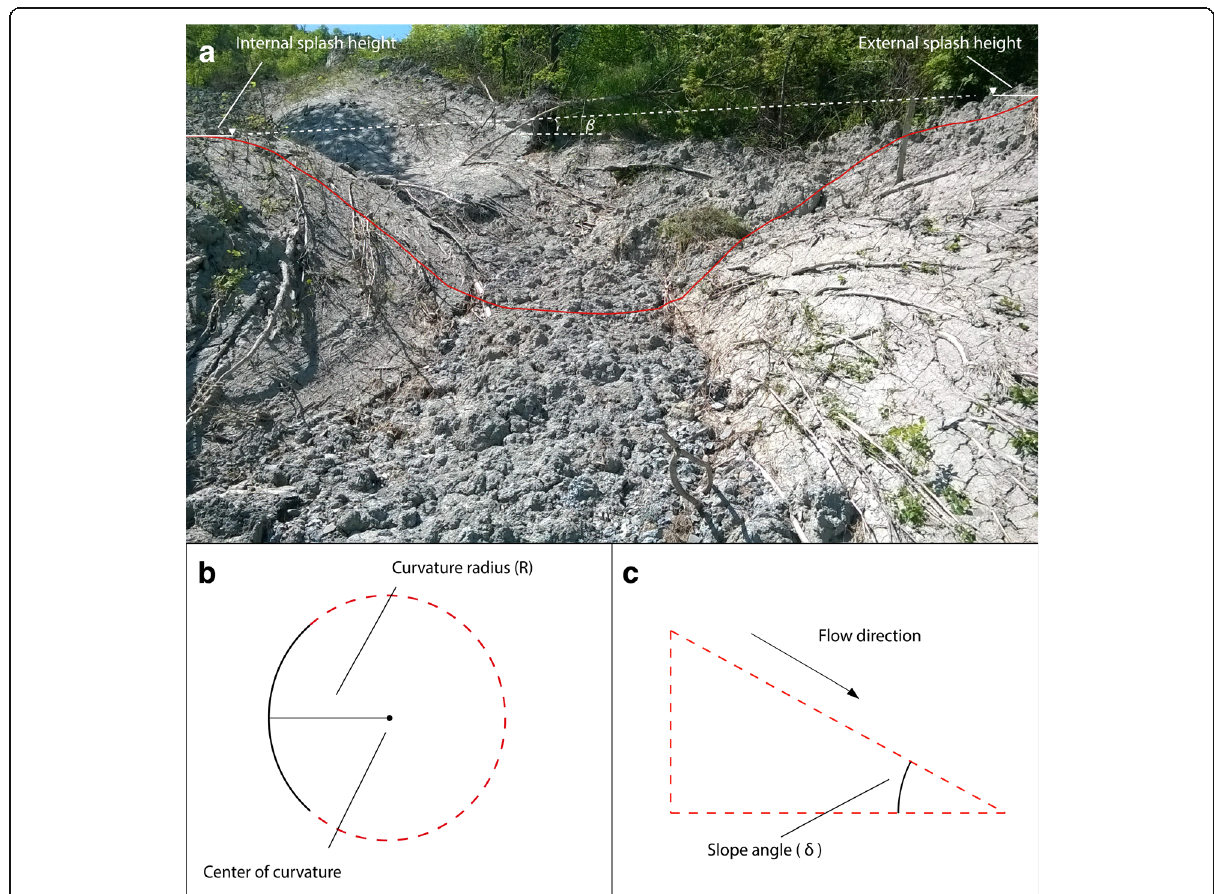
Fig. 9 Empirical formula parameters for flow velocity estimation: a ) splash heights on the inside and outside of the bends of the flow path (cross section 2); b ) radius of curvature; and c ) slope